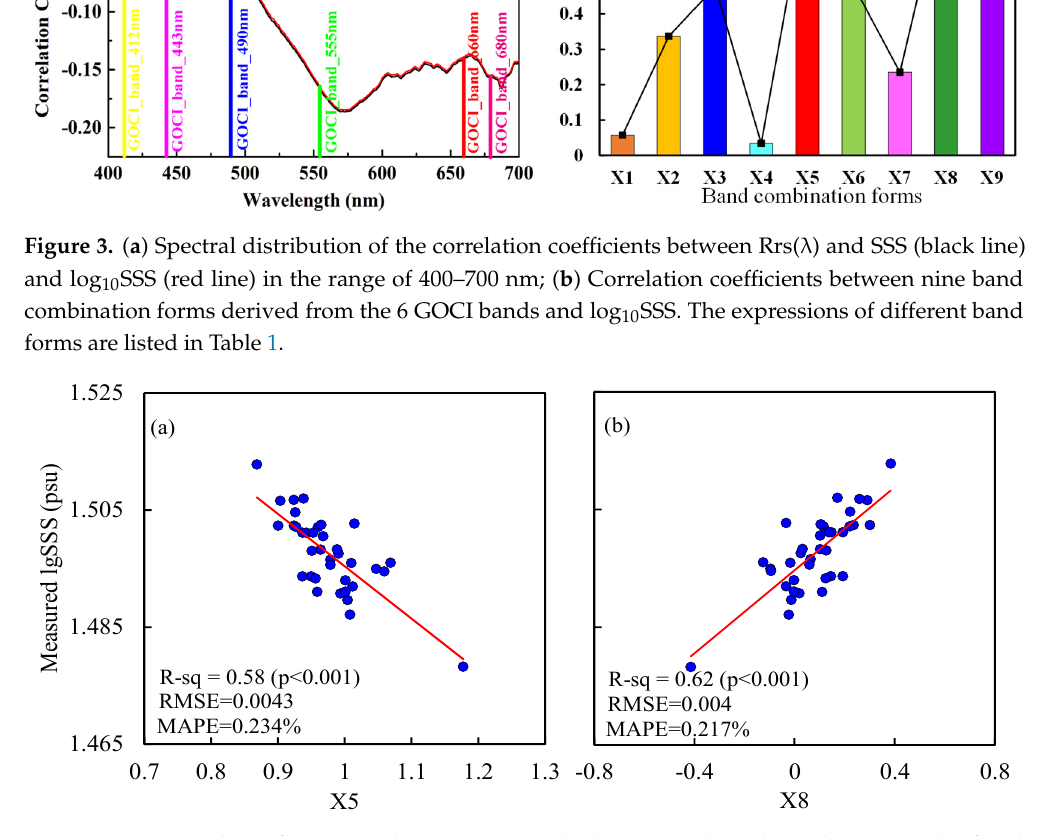
Figure 4. Scatter plots of ( a ) X5 and ( b ) X8 versus the log 10 SSS. The solid red lines are the fitted function curves.